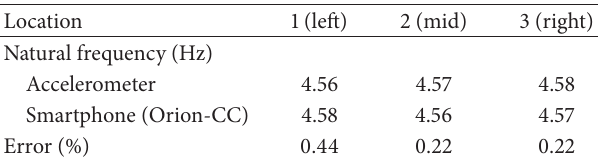
Table 6: Comparison of natural frequency identified from acceler- ation